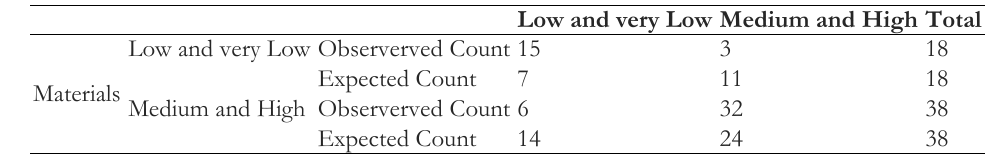
Table 5. Materials * design cross tabulation.